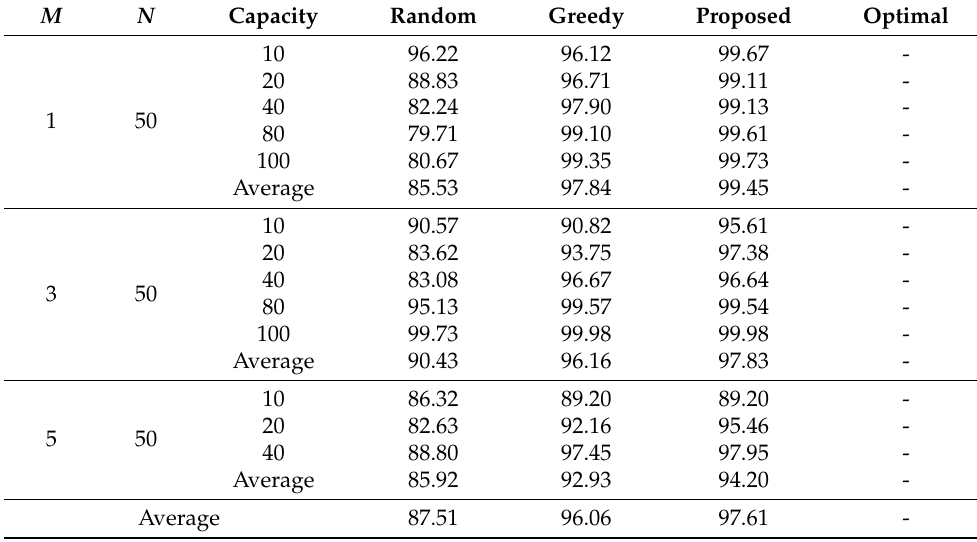
Table 6. The closeness to the optimal solution in QI set.